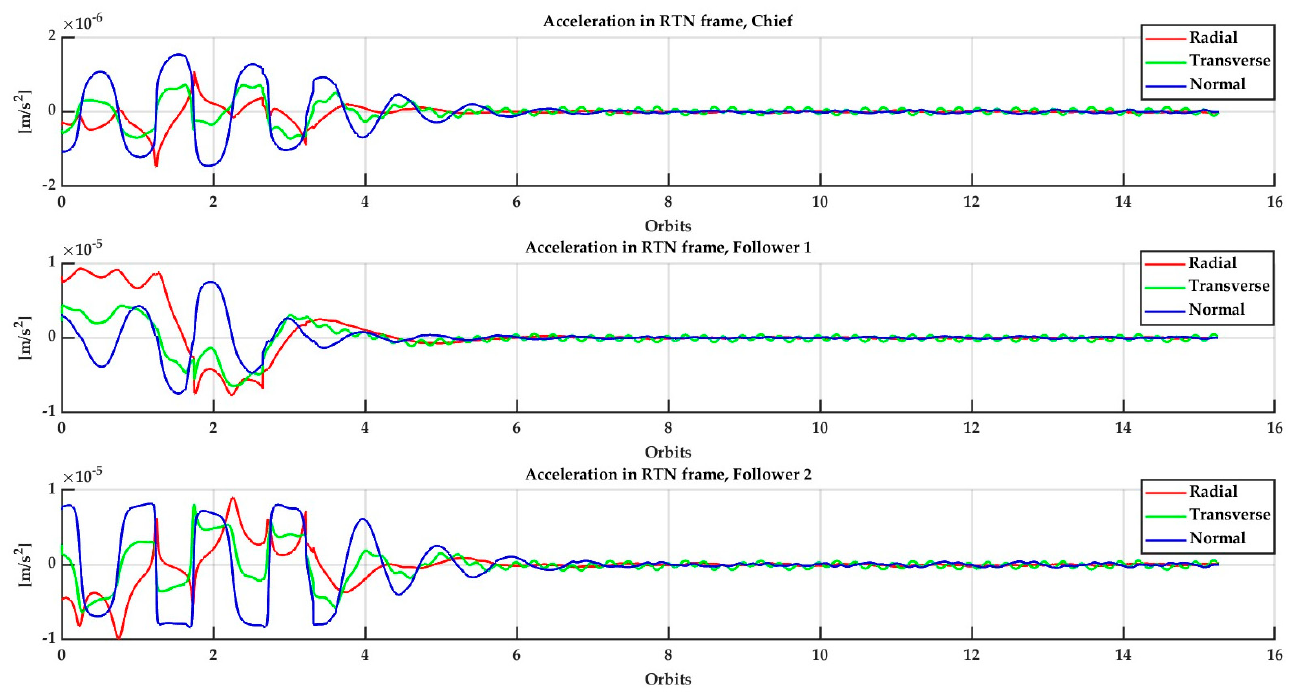
Figure 11. Control acceleration results with chief/follower mass ratio β = 2 .